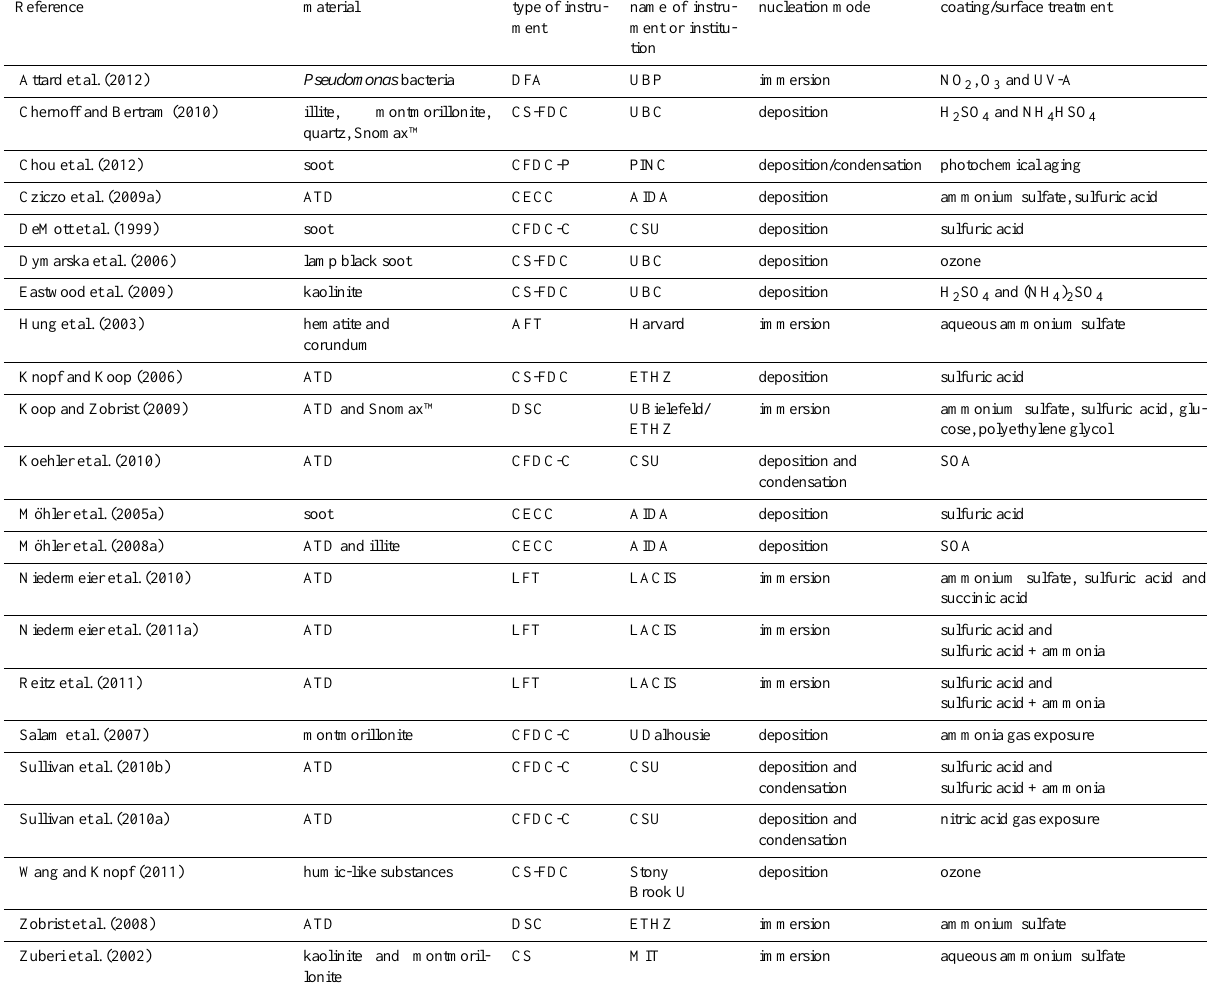
Table 6. Laboratory experiments with mineral dust, soot and other particles with coatings/surface treatments or in aqueous